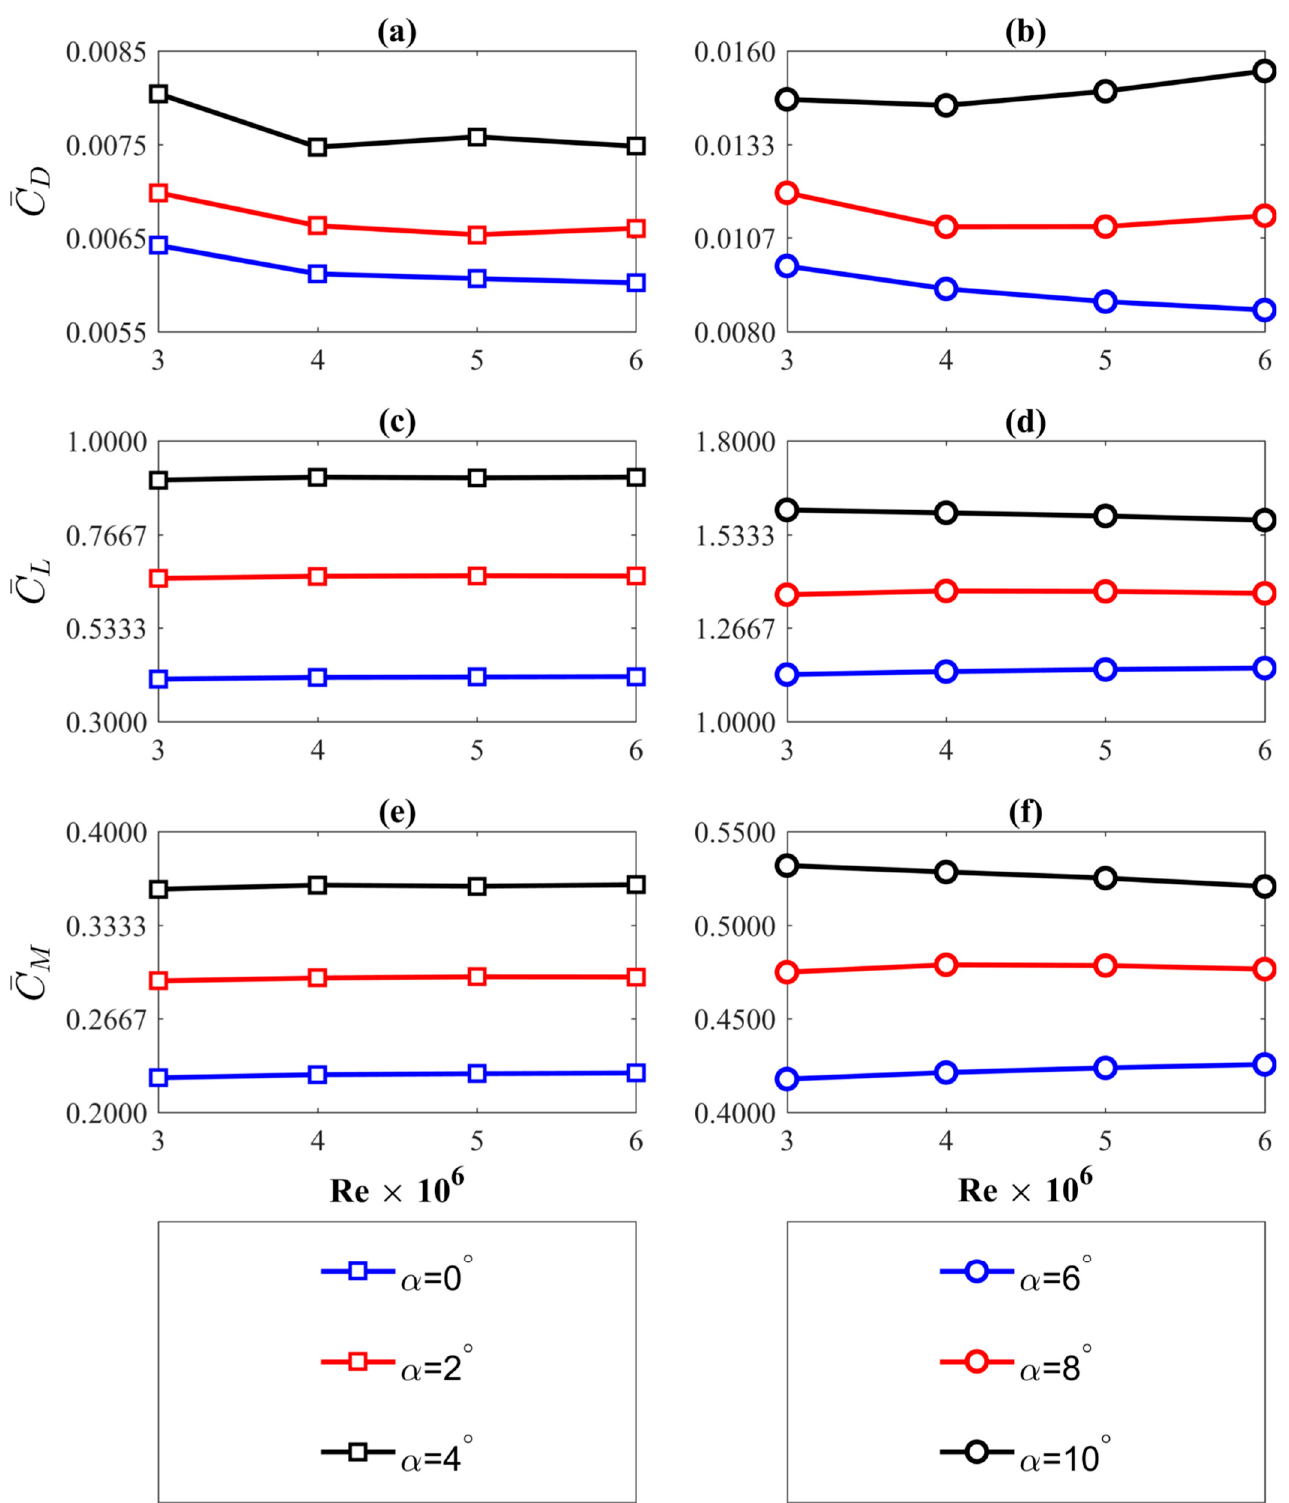
Figure 6. The drag and lift coefficients as a function of the Reynolds number for six angles of attack: ( a , b ) drag coefficients; ( c , d ) lift coefficients; ( e , f ) torque coefficients. The results are given only for URANS with the Transition SST turbulence model.